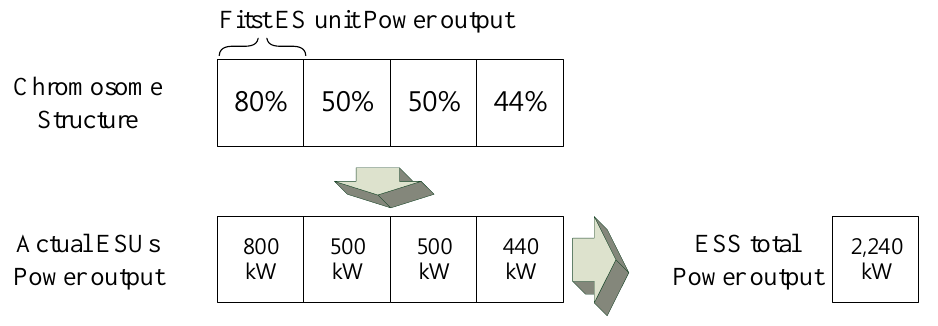
Figure 6. Structure of string chromosome.